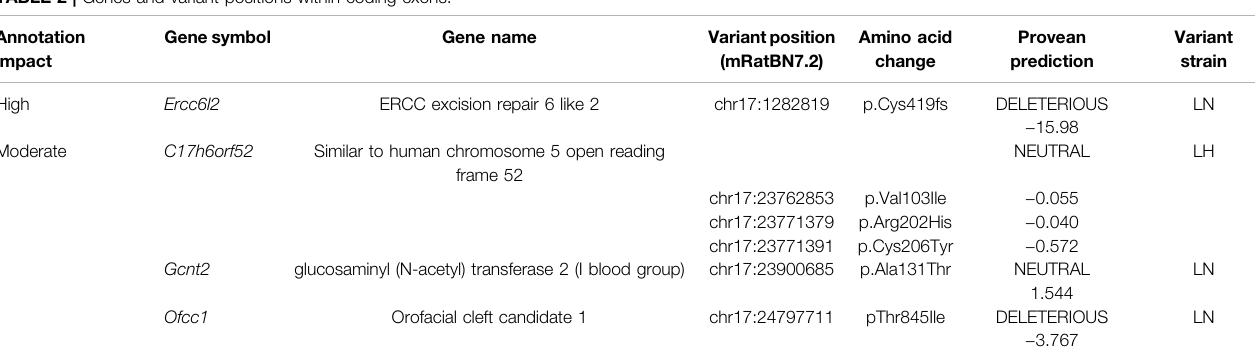
TABLE 2 | Genes and variant positions within coding